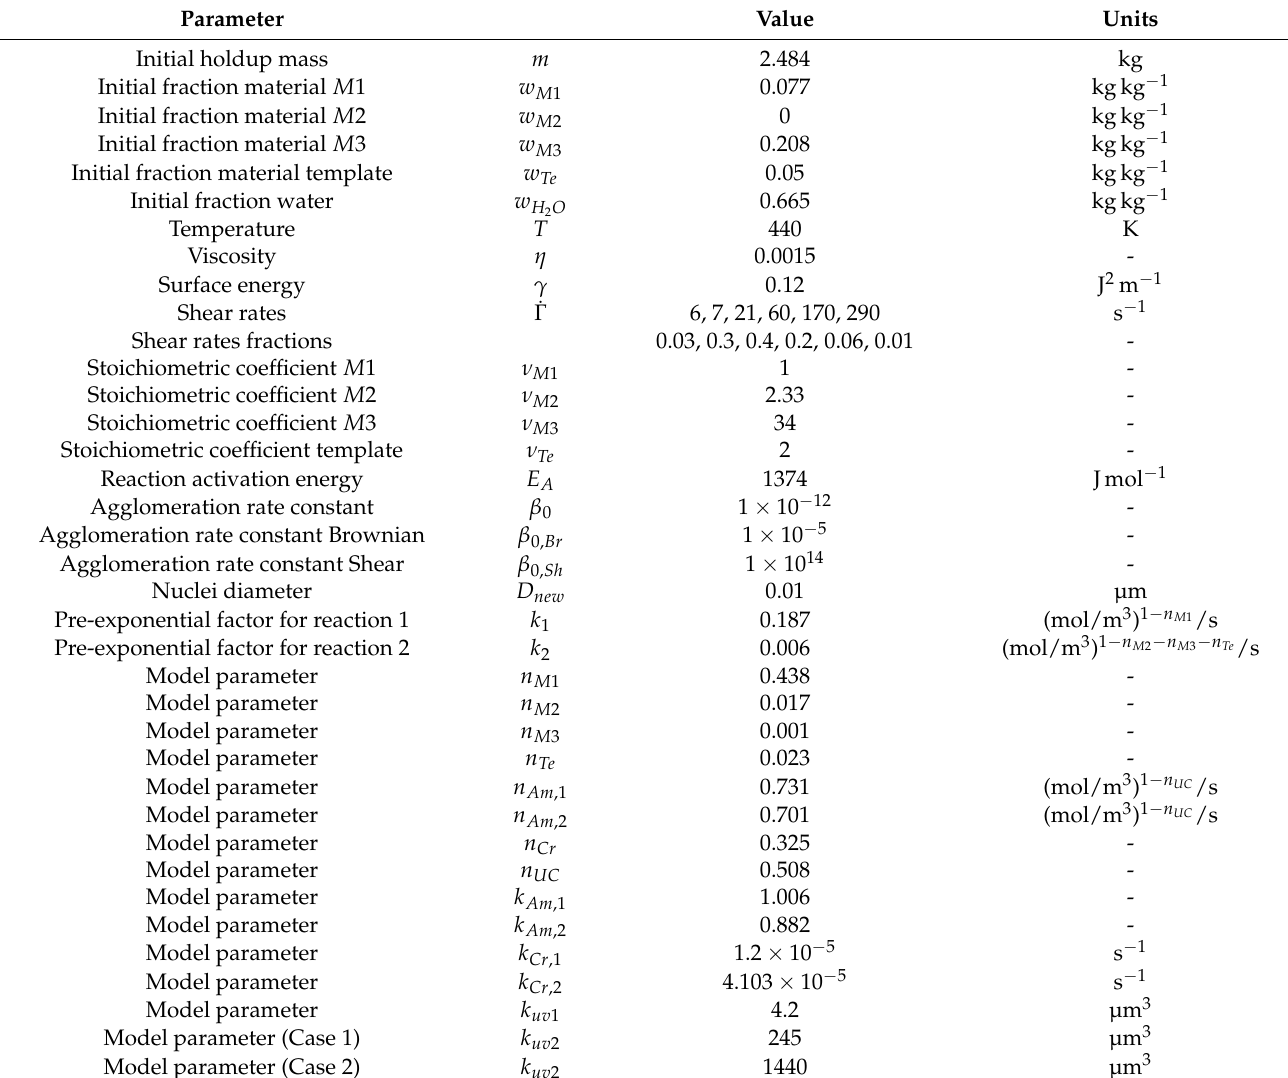
Table A4. Model parameters of the Synthesis unit used in the flowsheet simulations of the zeolite catalyst production process.